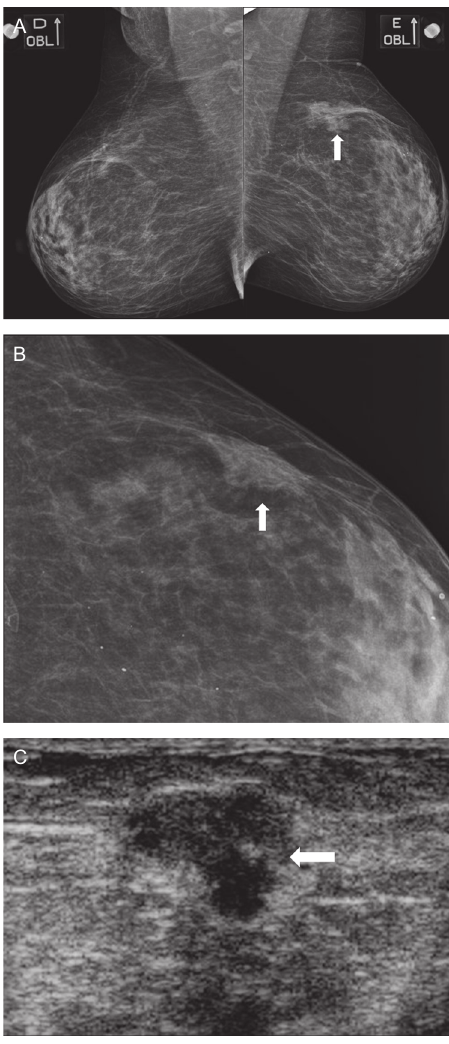
Figure 1A - Oblique view of both breasts. A focal asymmetry is seen in the left upper quadrant (arrow). B . Magnified cranio- caudal view showed an irregular mass lesion and indistinct margins (arrow). C . US revealed an irregular, hypoechoic mass with indistinct margins (arrow). Core biopsy revealed a Ductal Invasive Carcinoma.